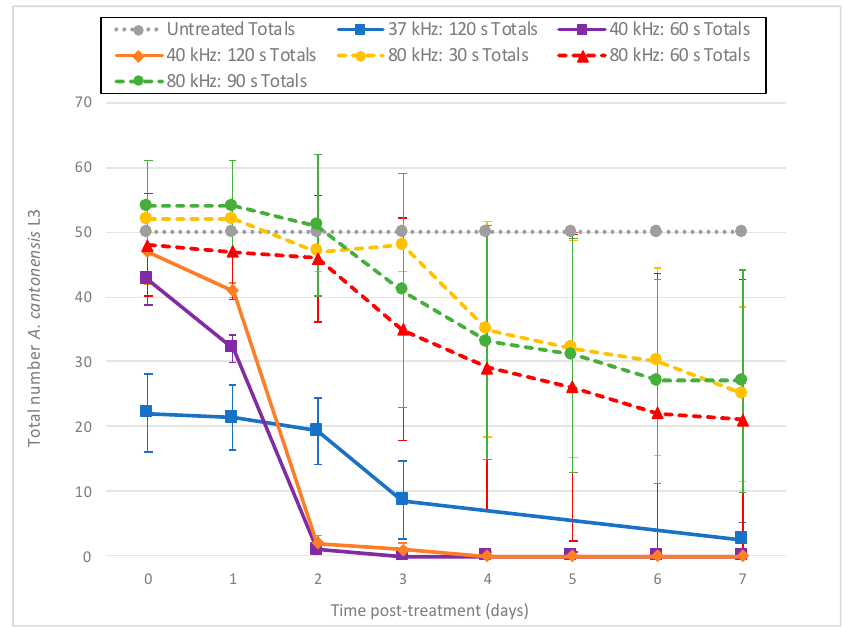
Figure 6. Decline in the total number of A. cantonensis L3 per day from exposure to ultrasound at 40 kHz (Branson 1510R-MT) and 37 and 80 kHz (Fisherbrand FB-11201). All tests were conducted in triplicate.